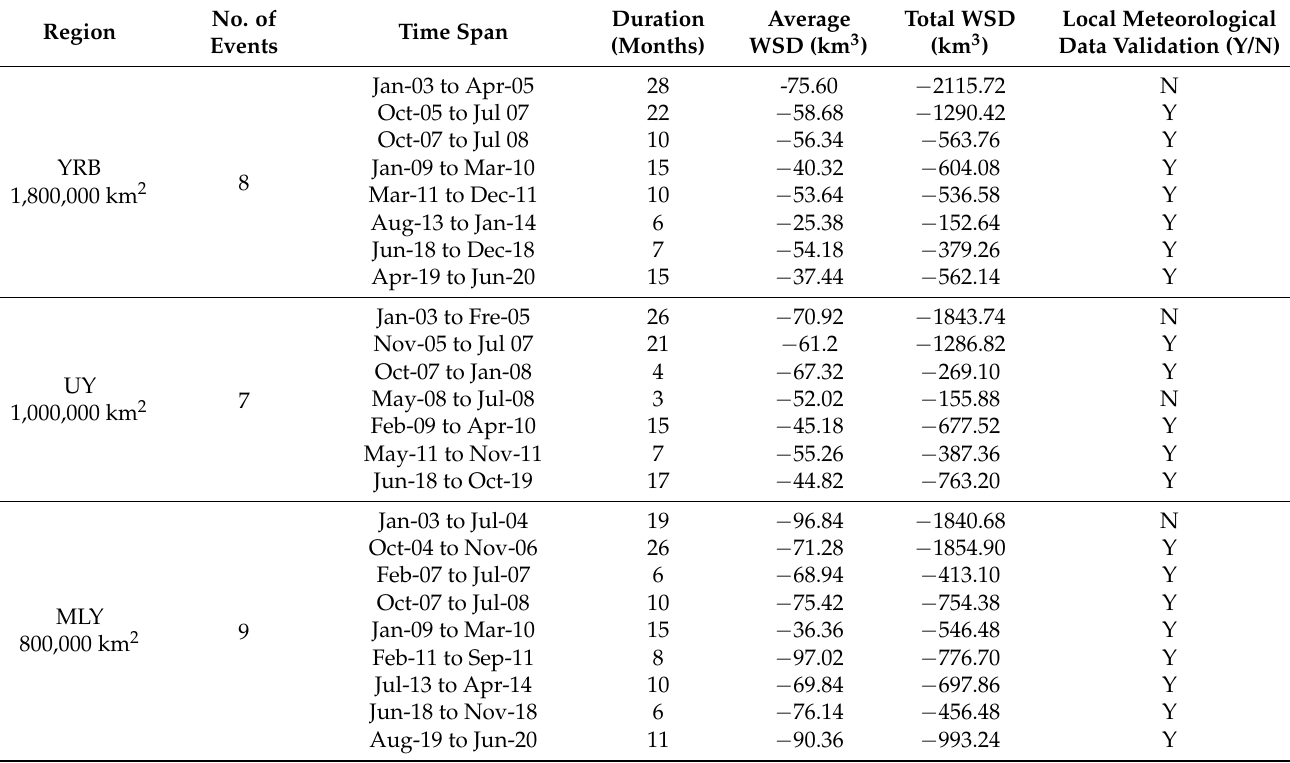
Table 1. Summary Table of drought events.